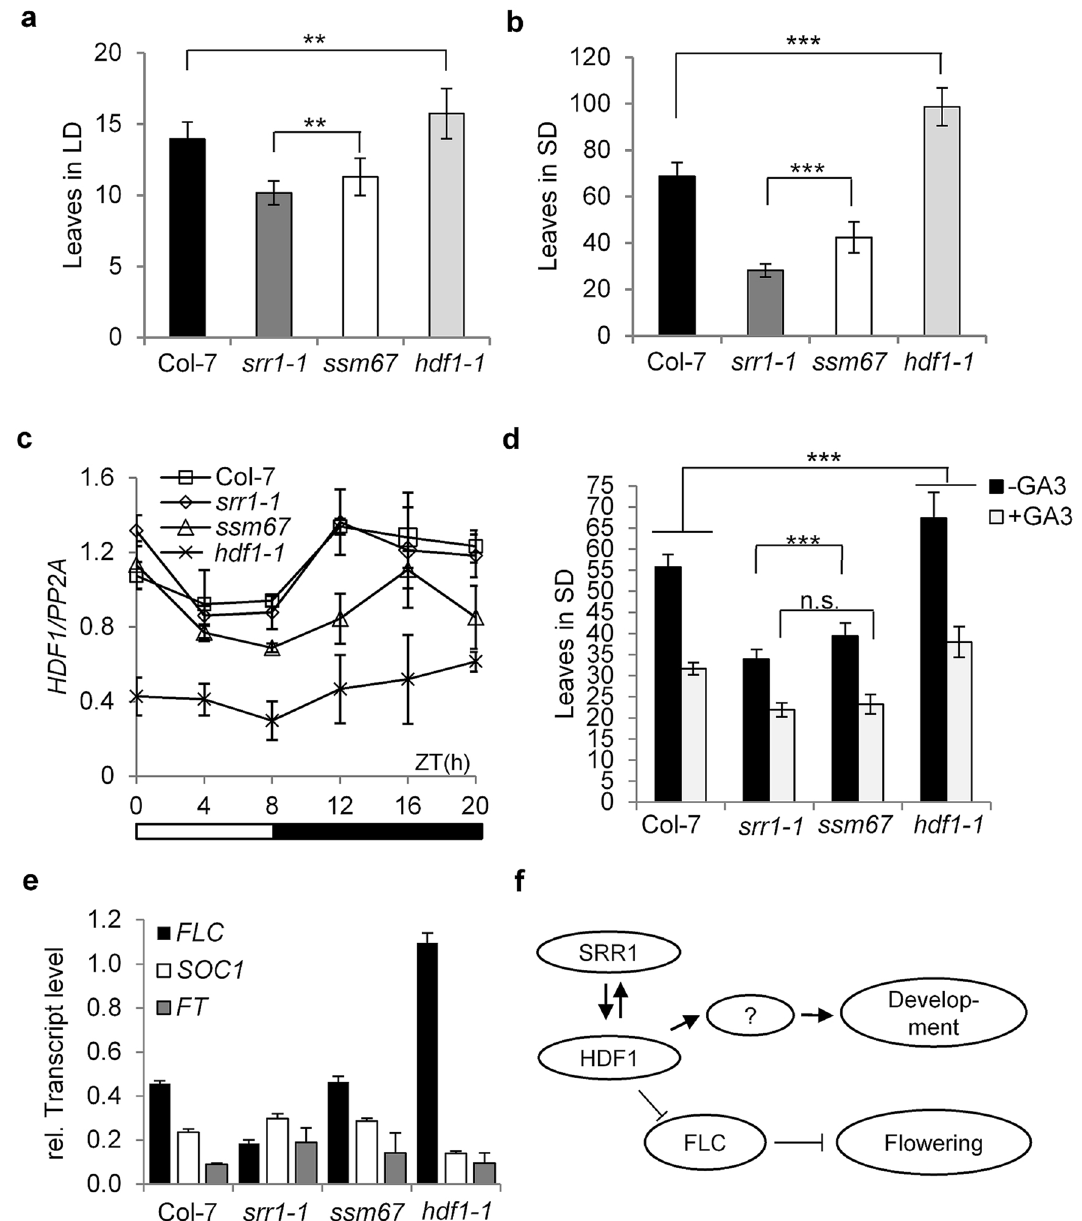
Figure 5. The role of HDF1 in flowering time control. Col-7 wt plants, srr1-1 , ssm67 and hdf1-1 single mutants selected from a backcross of ssm67 with Col-7 were grown in LDs ( a ) and SDs ( b ). The number of leaves was counted when the bolt was 0.5 cm in height (data are means ± s.d from n = 20–25 plants). A t test was employed to determine statistical significance (* P ≤ 0.05, ** P ≤ 0.01, *** P ≤ 0.001). ( c ) Expression levels of HDF1 . Col-7 wt, srr1-1 , ssm67 and hdf1-1 single mutants were grown in SDs and harvested at 4-h intervals over the course of on day. HDF1 transcript levels were monitored by RT-qPCR and normalized to PP2A . Data are means ± s.d. of three biological replicates. ( d ) Flowering time in response to GA. Plants were grown in SDs and sprayed with 100 µM GA 3 or 0.1% DMSO as control (data are means ± s.d from n = 20–25 plants). A t test was employed to determine statistical significance (*** P ≤ 0.001, n.s . not significant). ( e ) Expression levels of FLC, SOC1 and FT . Plants were grown in SDs for three weeks and harvested at zt4. Transcript levels were monitored by RT-qPCR and normalized to PP2A . Data are means ± s.d. of three biological replicates. ( f ) Proposed working model for the regulation of flowering time and vegetative development through HDF1 and SRR1. Flowering is inhibited by FLC while vegetative development could be influenced indirectly by additional unknown